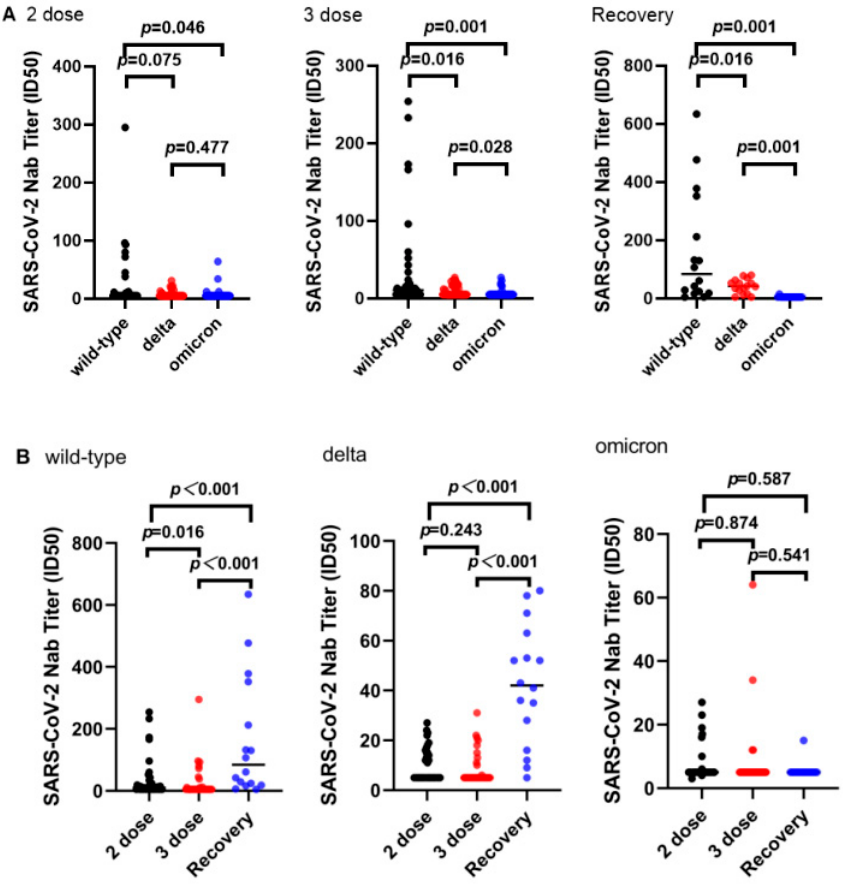
Figure 2. Comparison of ID50 values for different individuals and different pseudoviruses. ( A ) Three pseudoviruses (wild-type, Delta, and Omicron variants) were compared in terms of ID50 values among different study subjects (two-dose vaccinees, three-dose vaccinees, and recovering patients), respectively. ( B ) Different study subjects (two-dose vaccinees, three-dose vaccinees, and recovering patients) were compared in terms of ID50 values against three pseudoviruses (wild-type, Delta, and Omicron variants), respectively.